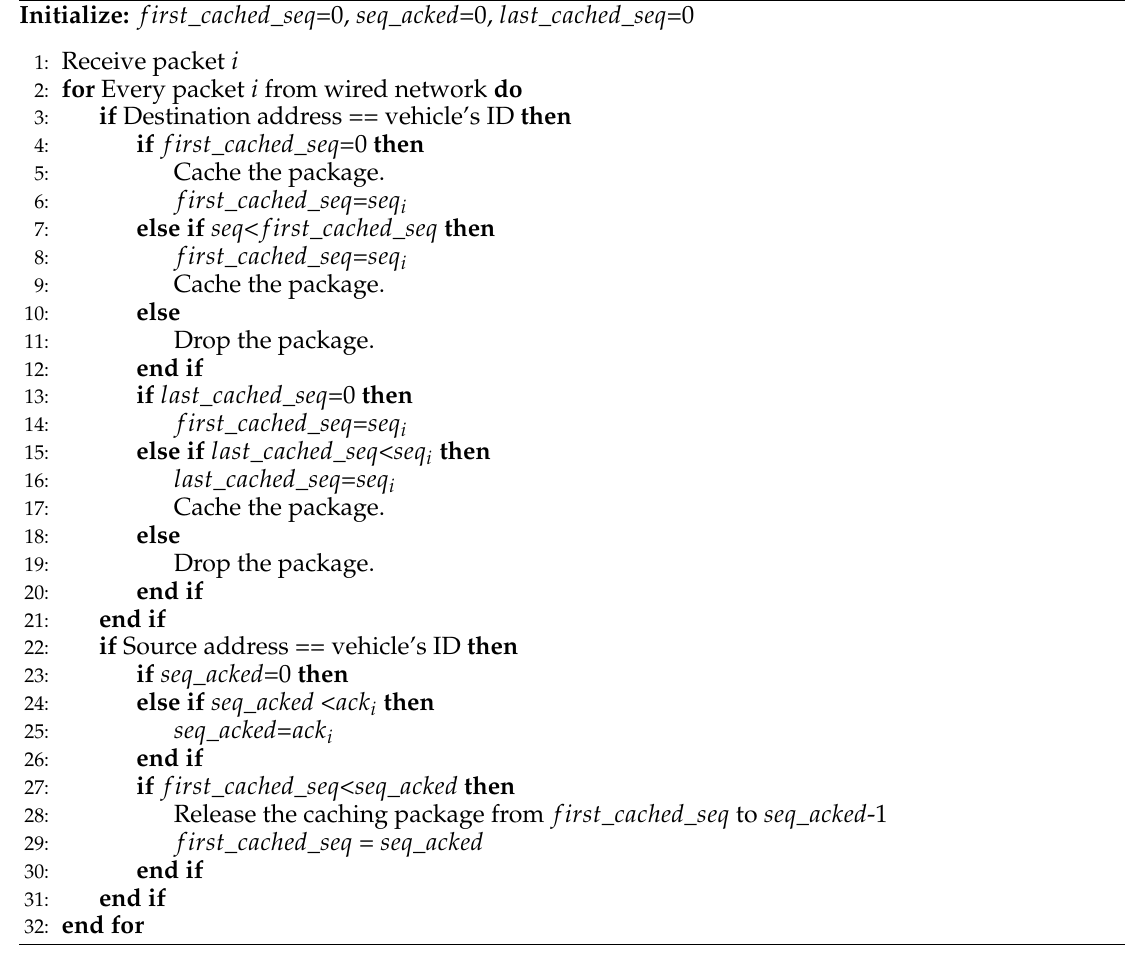
Algorithm 1 Caching algorithm at base